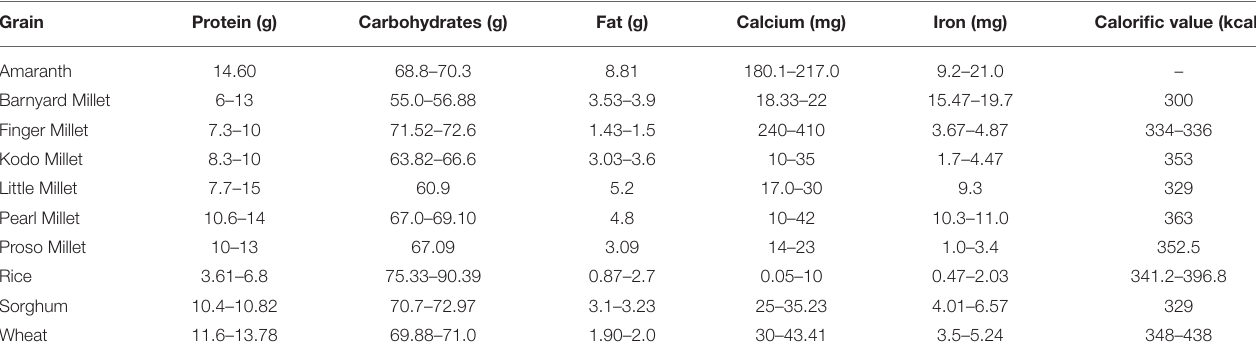
TABLE 1 | Nutritional Comparison of Millets, Amaranth, Rice, and Wheat (per 100g) (Valcárcel-Yamani and Caetano da Silva Lannes, 2012; Saleh et al., 2013; Kumar et al., 2018; Nithiyanantham et al.,